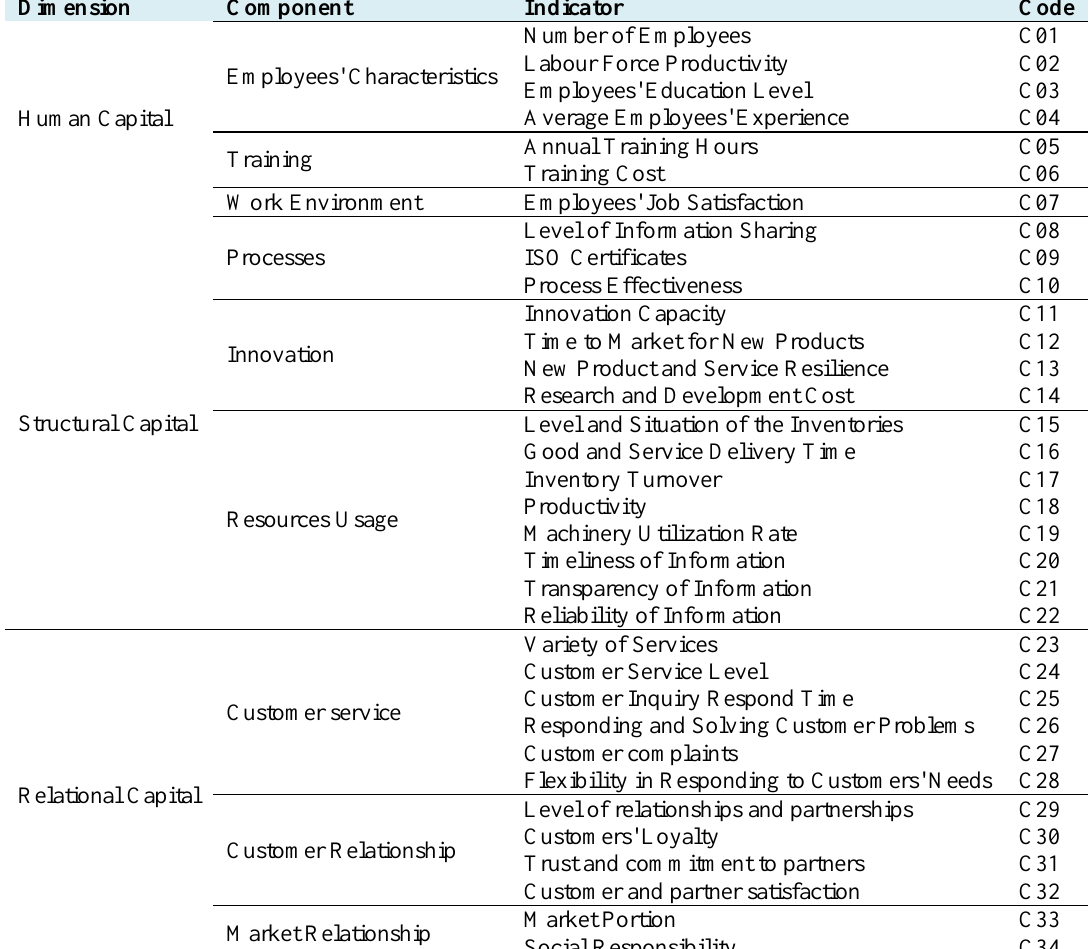
Table 3. Dimensions, Components, and Indicators of Modified Model